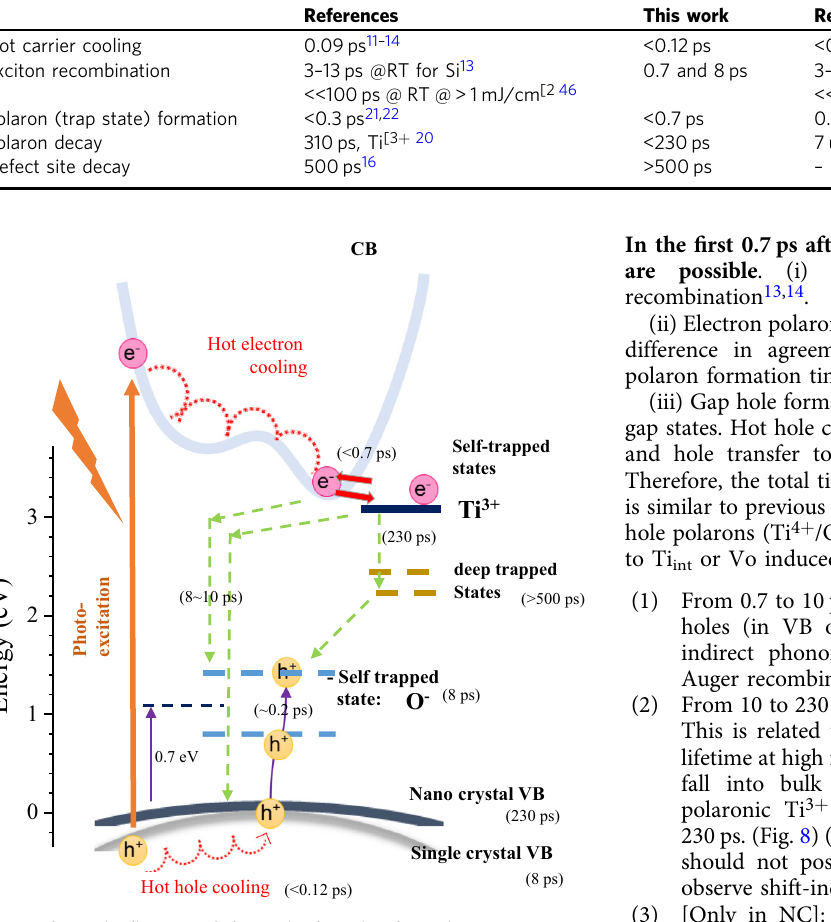
Fig. 8 Schematic diagram of the excited carrier dynamics at room temperature. The pump laser excites an electron from VB to CB and thereby generates an e-h pair. Holes deeper than VBM transfer to VBM. Holes at VBM eithertransfer to gap states or stayin VB. One of the possiblegap states can be a self-trapped hole state (Ti-O − ) 6,9 . Excited electrons are seen in XAS as fast-increasing features followed by fast-decaying features in between peaks (Ti 3 + ) of the ground state XAS spectrum. These fast features re fl ect transient localization of the electron cloud to Ti atoms (Ti 3 + -O) 4 . Most of the localized electrons (80%) recombine with holes very rapidly and only a portion of the electrons (20%) remain. The fast-decrease followed by very slow-decay features at peak positions (Ti 4 + ) of the ground XAS spectrum represent the CB electron, effects resulting from geometry relaxations induced by the fast transient electrons, or electrons in deep trap sites.